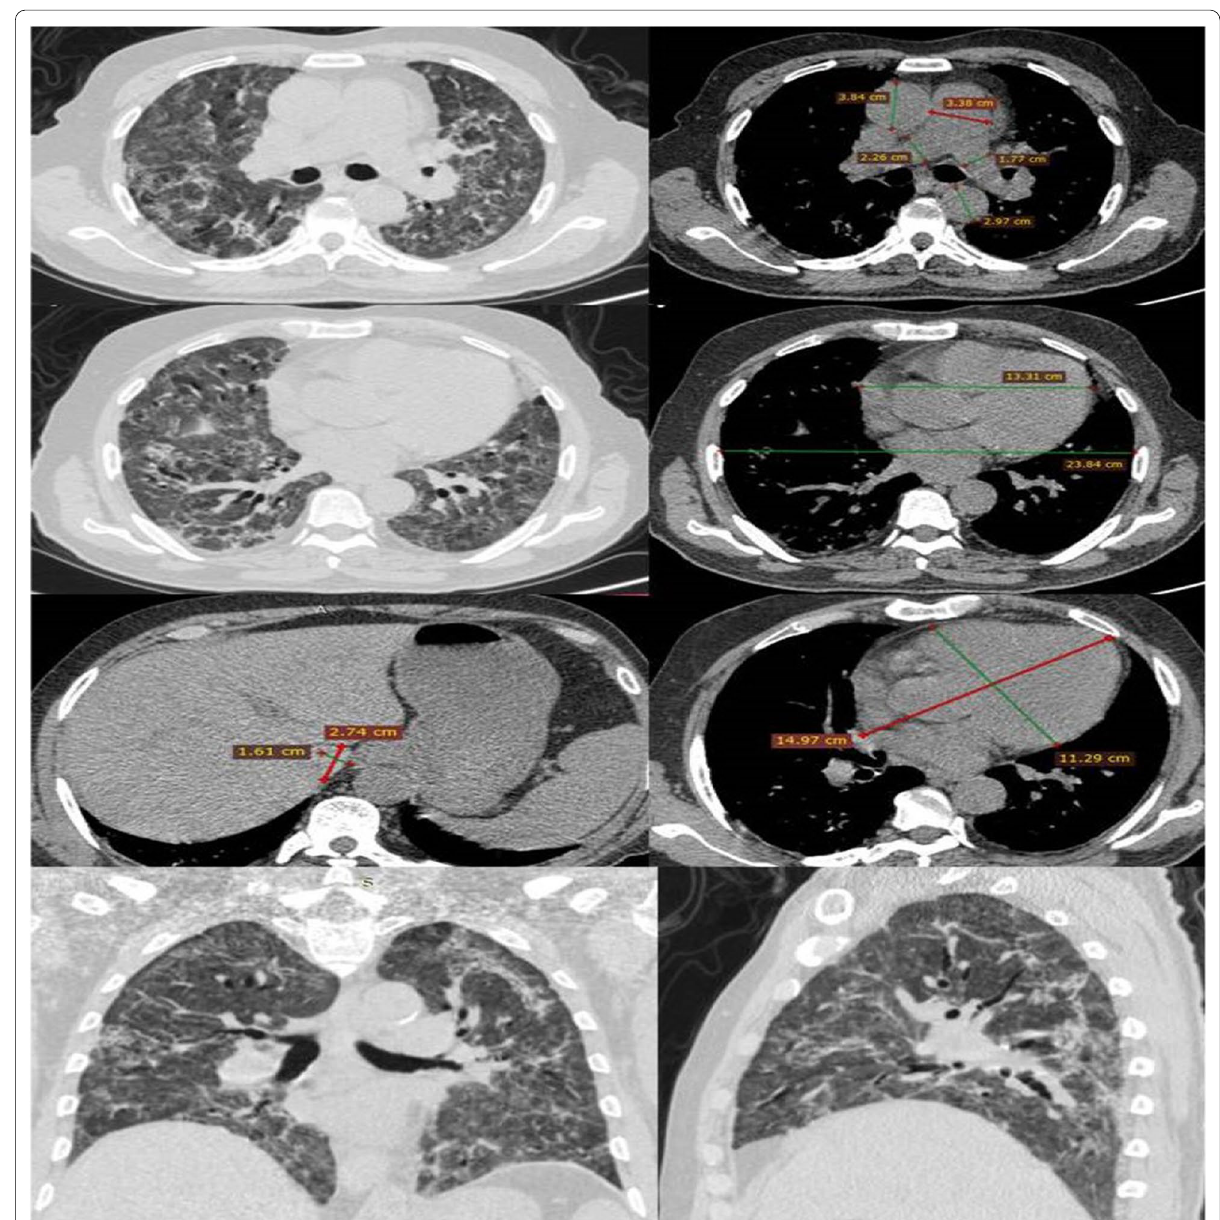
Fig. 2 Illustration of the cardiovascular CCT parameters and lung radiological findings in a deceased critical COVID‑19 patient. This figure relates to a 58‑year‑old deceased COVID‑19 male patient who suffered from critical symptoms. The predominant lung patterns are GGO and crazy paving opacity bilaterally. This patient has an overall CCT lung involvement score of 24. In addition, it should be noted that cardiomegaly (CTR > 0.49) is present, the PA/AA ratio is 1, and the right pulmonary artery diameter is greater than the ≤